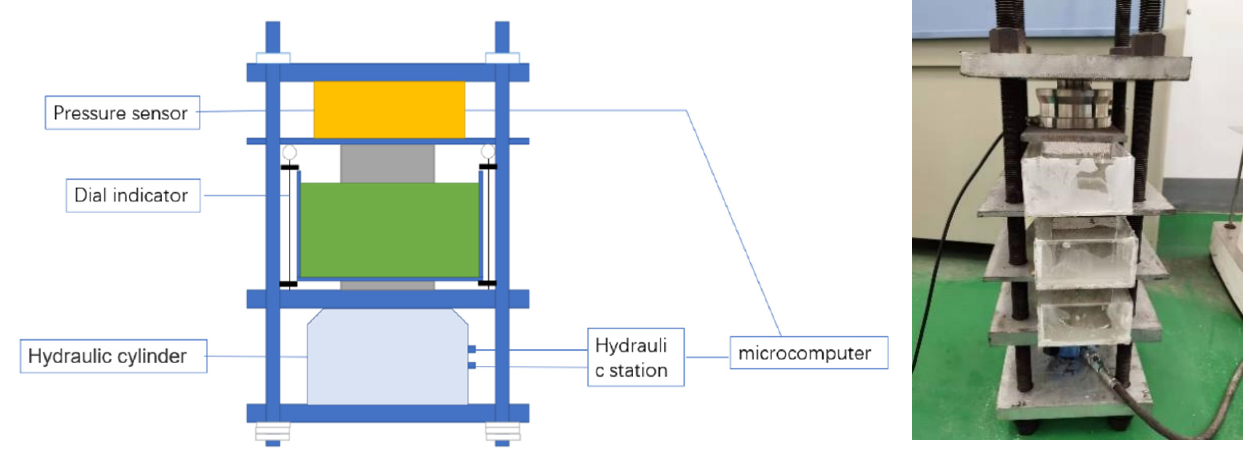
Figure 4. Continuous pressurized load and seawater joint action test equipment.